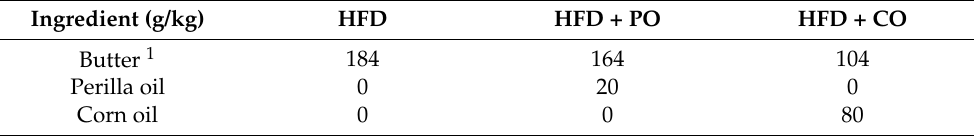
Table 2. Variable ingredients in the three experimental